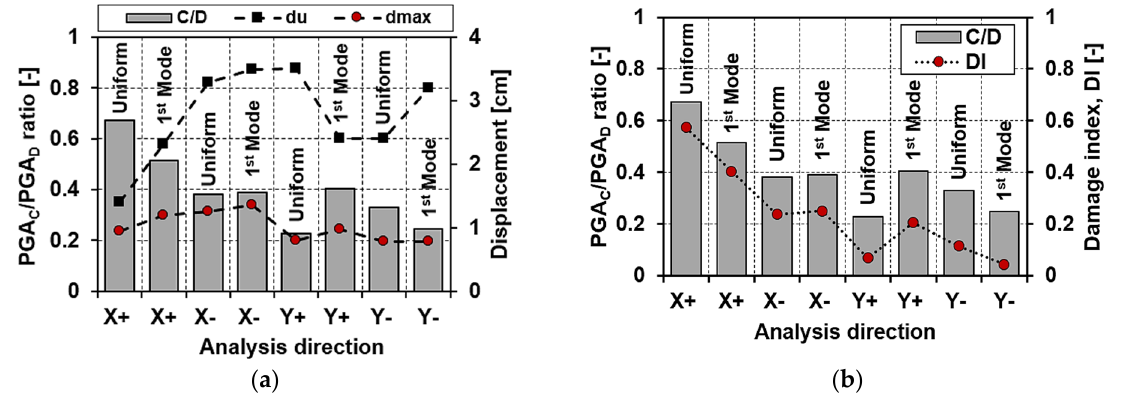
Figure 9. Estimated mechanical vulnerability index (V I ) ( a ) and damage index (DI) ( b ).